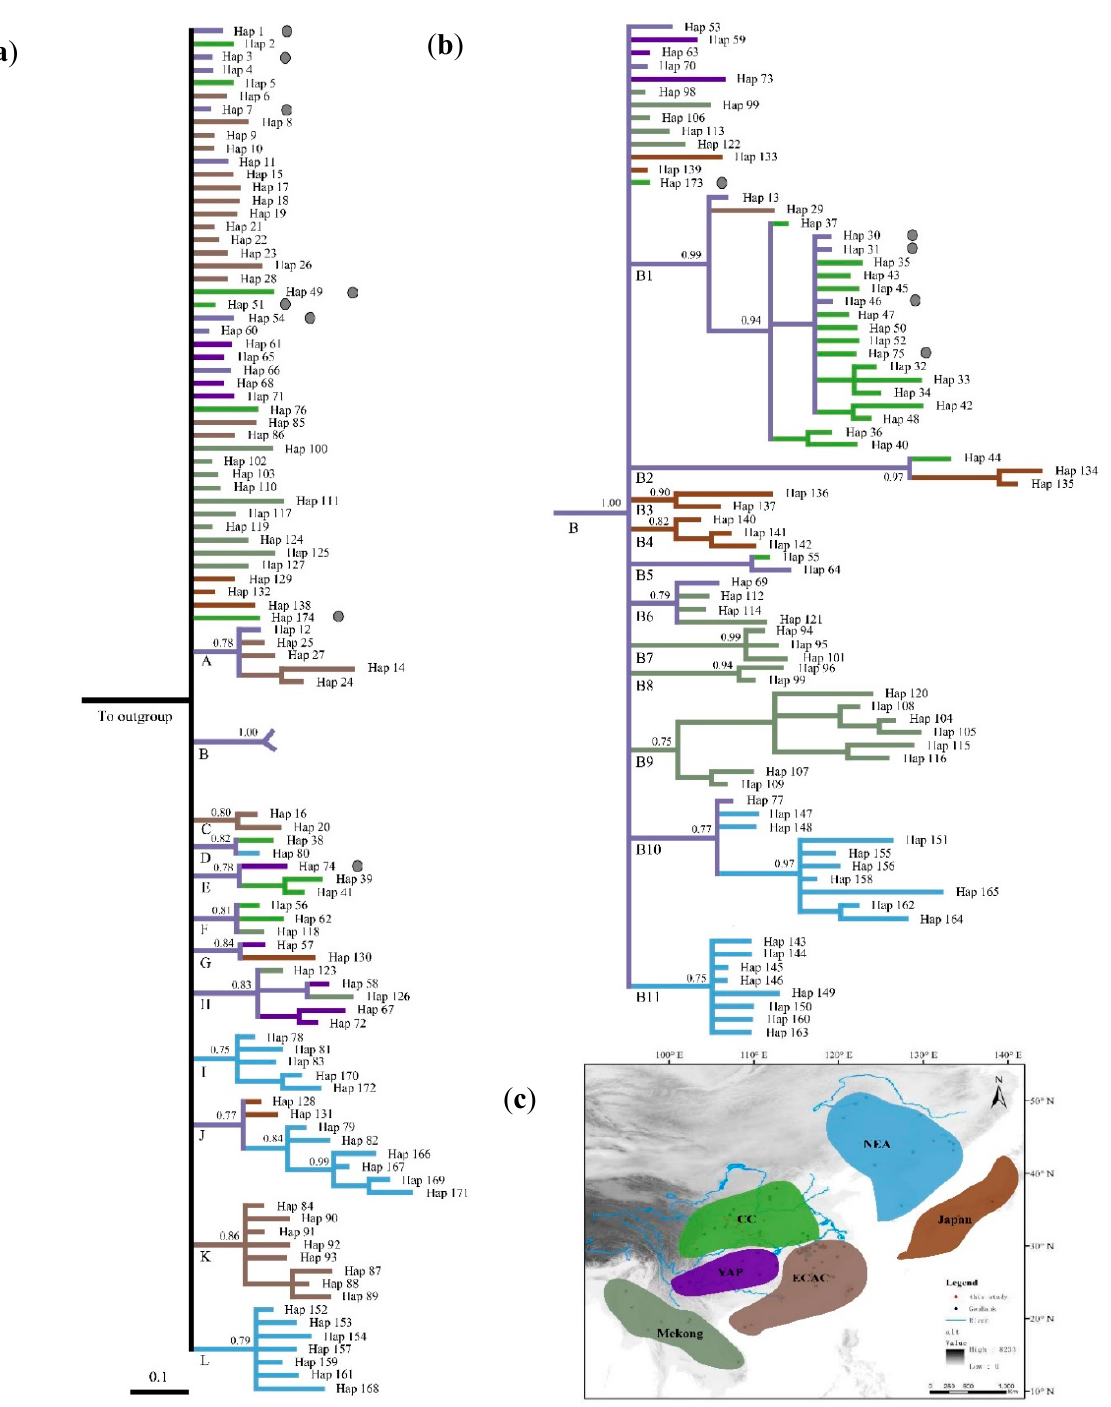
Figure 3. ( a ) Bayesian inferenced tree of East Asian wild boar based on 511 bp mtDNA control region sequences. Numbers above the tree branches are posterior probabilities, and letters under the tree branches represent the name of each clade. The black dots represent the haplotype found in QM area. The color of branches represented samples’ geographical regions corresponding to ( c ). ( b ) The detailed structure of the Clade B. ( c ) Map showing the distribution and sampling localities used in this study. NEA, Northeast Asia; CC, Central China; ECAC, the eastern coastal areas of China; YKP, Yunnan–Kweichow Plateau; Japan, Japan Island; Mekong. The black circles represent samples used in this study; the red circles represent samples downloaded from